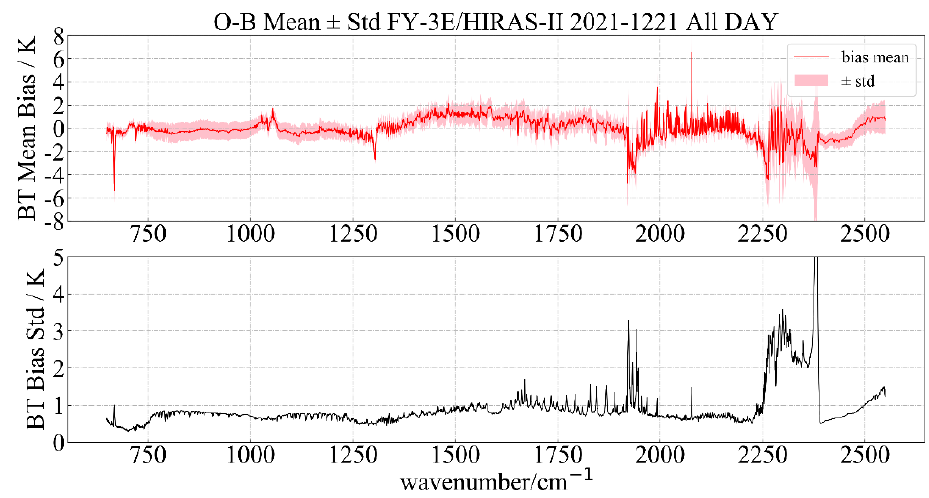
Figure 5. Comparison of FY-3E/HIRAS-II observed and simulated brightness temperature. In Figure 5, the blue curve is the observed brightness temperature of HIRAS-II and the red curve is the HIRAS-II simulated brightness temperature obtained by RTTOV. The observed brightness temperature was generally consistent with the simulated brightness temperature.